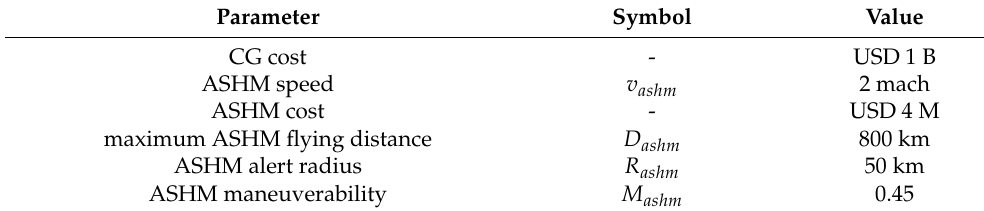
Table 6. Parameters of CG.